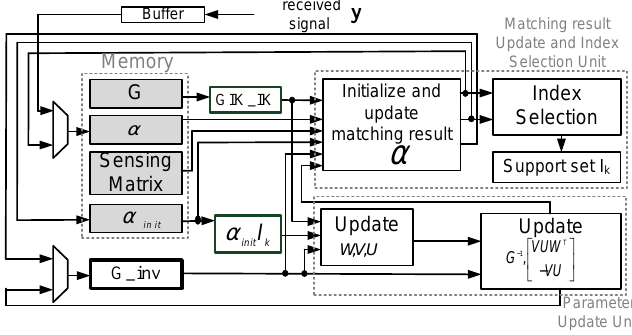
Figure 10. Block diagram of the proposed